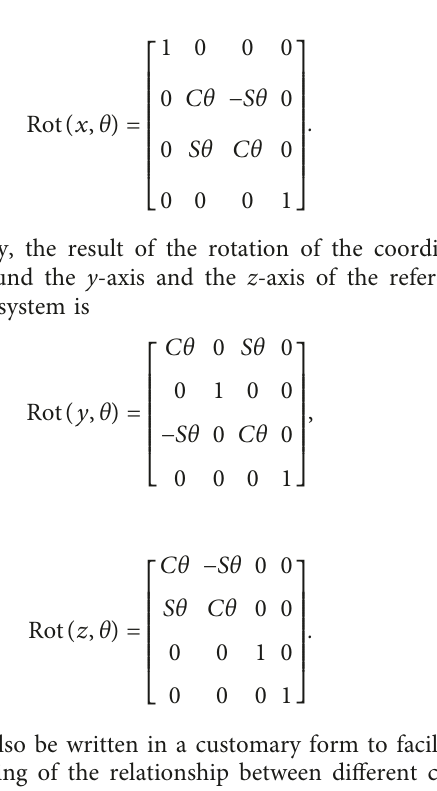
Figure 12: The structural principle diagram of the Agent software for optimization and matching of machining